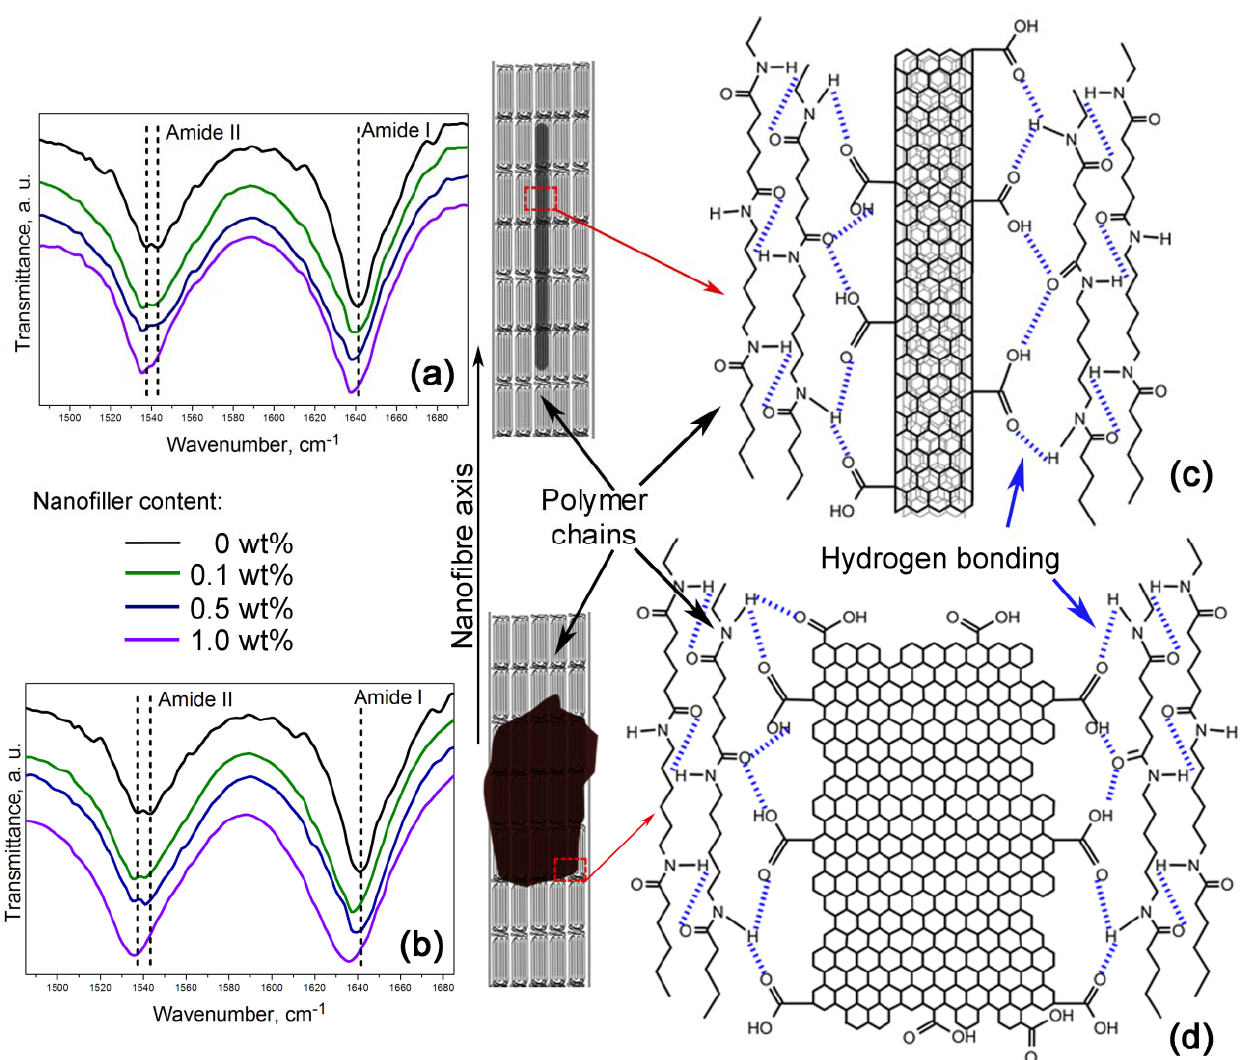
Figure 6. Nanofibres intramolecular bonding in the ( a , c ) PA66/OCNTs and the ( b , d ) PA66/GO